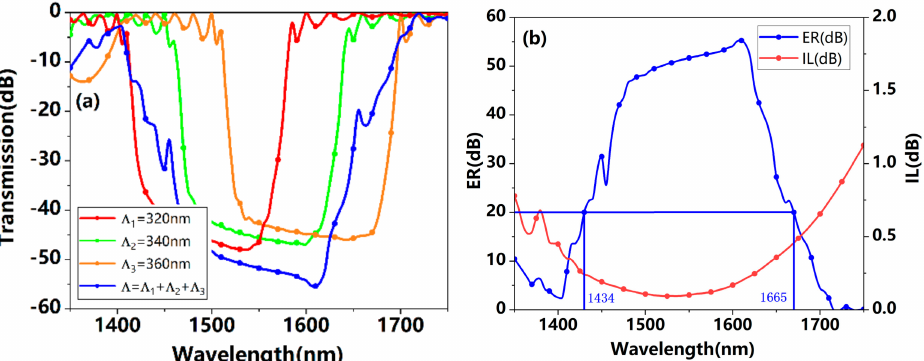
Figure 6. ( a ) Transmittances under gratings periods of 320 nm (red), 340 nm (green), 360 nm (brown), and the superposition of the three periods (blue); ( b ) The extinction ratio and insertion loss of the proposed polarizer with a length of 15.3 µ